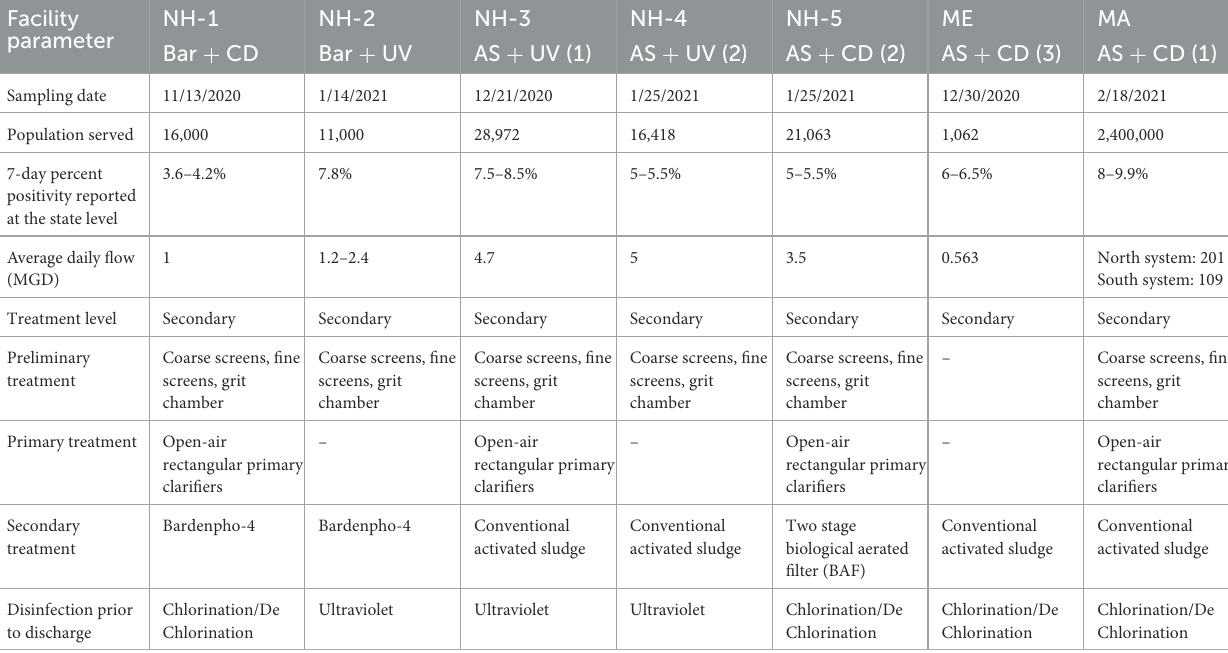
TABLE 1 Characteristics of wastewater treatment plants surveyed in this